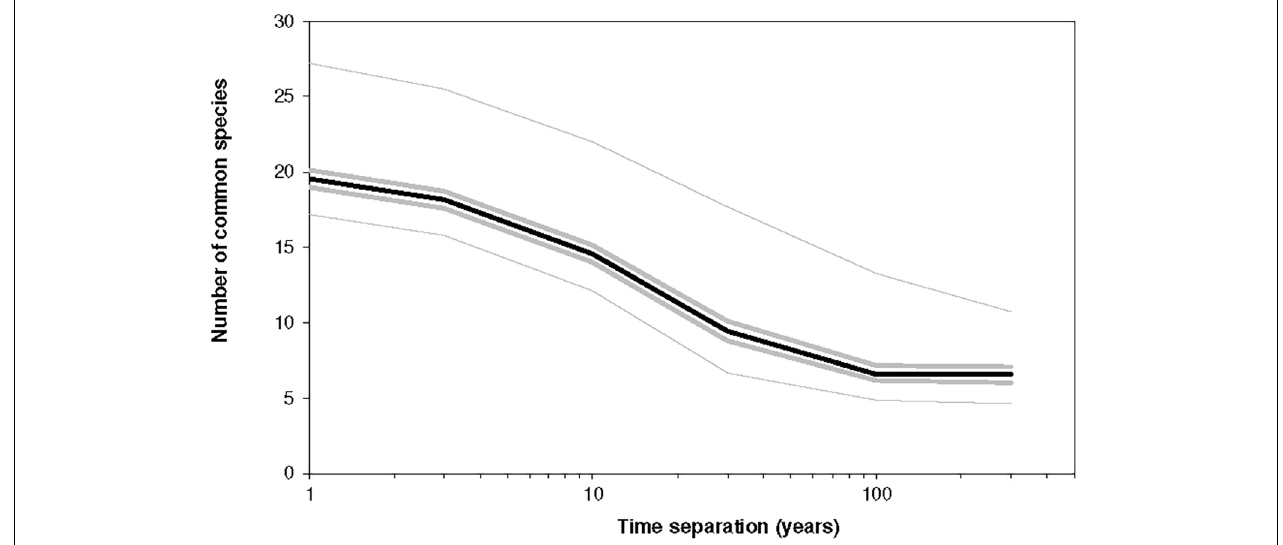
FIGURE 8 | The number of common species between two instances of a community separated by (cid:49) t years for different values of (cid:49) t . The parameters were K = 6 and B = 1.5, J = 10 4 , and the simulation covered 750 time-steps. Initially, the community was unoccupied, but each niche was subject to a colonization probability of 0.02/year with an MVP of 22. The average diversity in any year (for the interval t = 50 to t = 750) was 21.3 ± 4.4 species, and the population was on average 4,000. The lines indicate the median, minimum, maximum and the two hinges (25th and 75th percentiles) for 1,000 replicates. The dynamics are according to Equations (11)–(13) and thus include extinction-colonization.